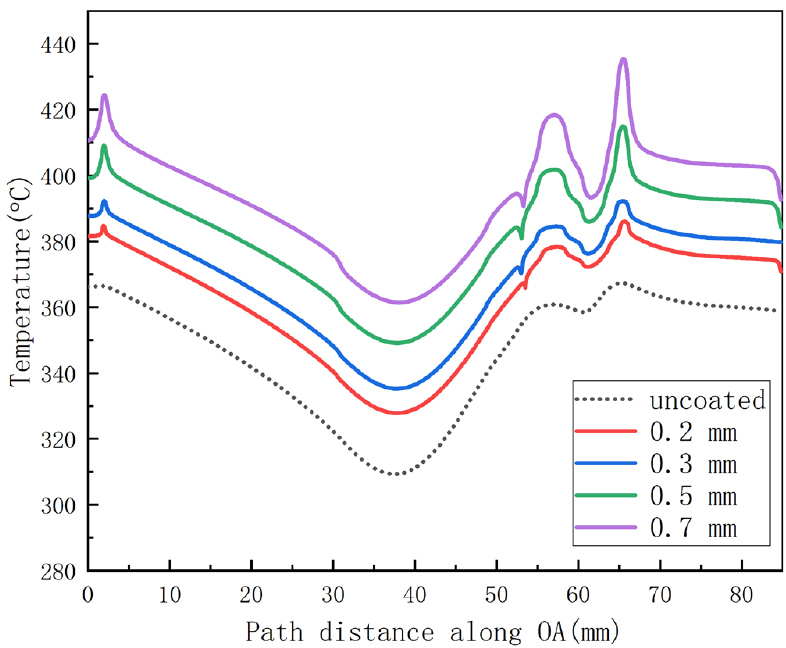
Figure 9. Topcoat surface temperature distribution with coating thickness along the path distance OA. The relationship between the temperature of the substrate surface and the radial distance along the path can be seen in Figure 10. The maximum temperature variations for coating thicknesses of 0.2, 0.3, 0.5, and 0.7 mm were 2.4%, 3.8%, and 5.7%, and 7.8% for the substrate surface. The decrease in the temperature of the piston substrate had a positive impact on the reliability of the